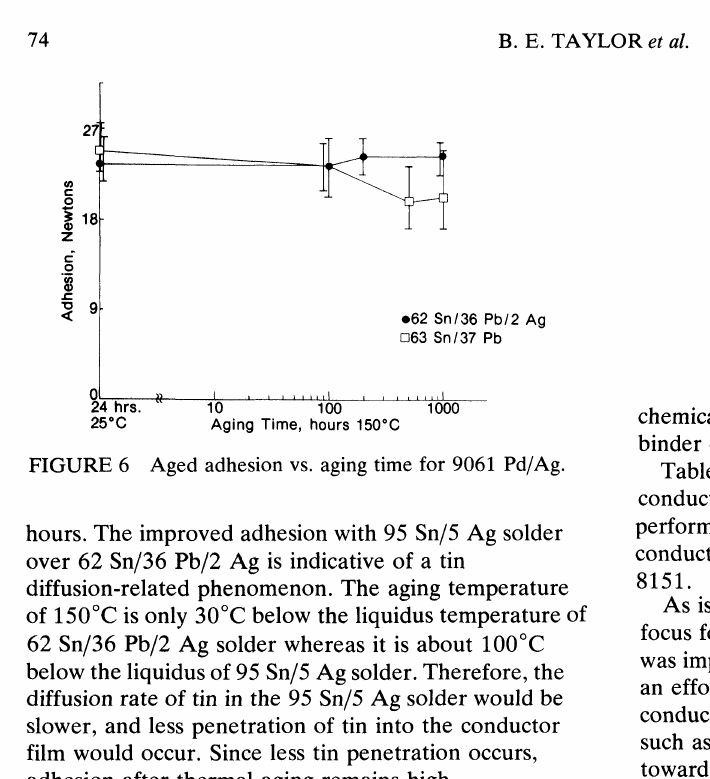
TABLE IV Adhesion results for silver-bearing conductors.